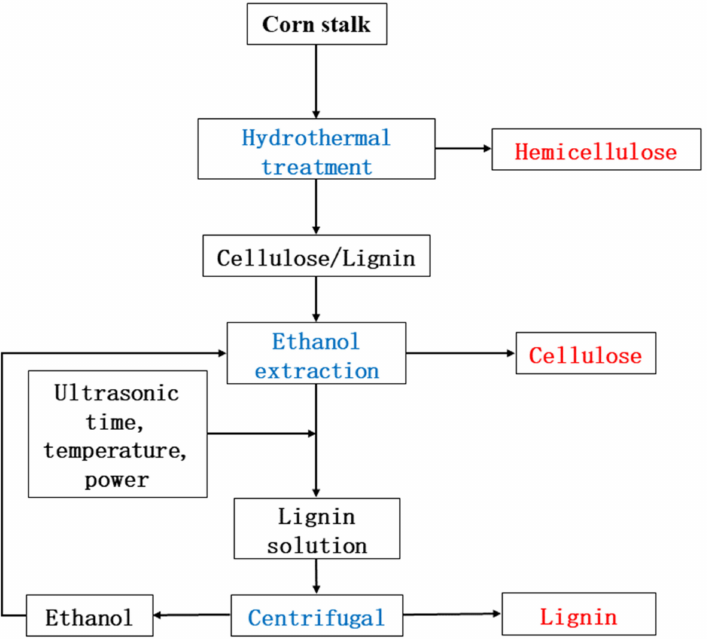
Figure 1. The overview of hydrothermal—ultrasonic ethanol